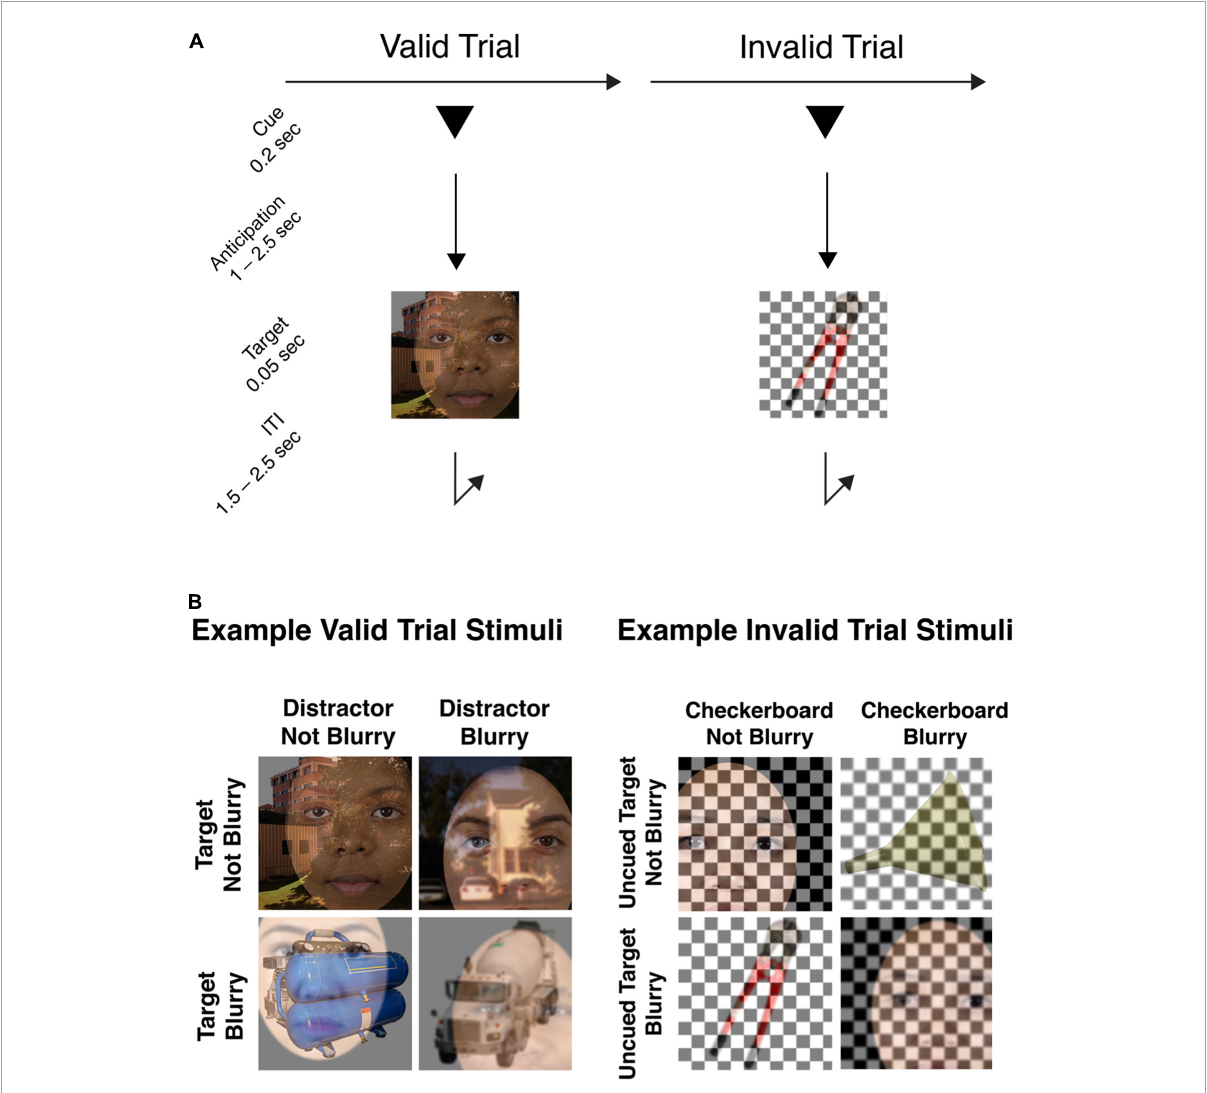
FIGURE1 (A) Example trial sequence. Each trial began with the presentation of a symbolic cue that was predictive of the upcoming object category (80%). Following an anticipation period (cue-to-target) varying from 1.0 to 2.5 s, a composite stimulus image was presented. Participants were required to make a rapid-accurate discrimination of whether the cued object image was blurry or not-blurry (valid trials), or whether the uncued object image was blurry or not-blurry (invalid trials). (B) Example stimulus images in the attention task. In the set of example valid trial stimuli shown, Face is the target object category to be identified as in-focus or blurry, and the overlaid Tool or Scene images are the distractor images. For each stimulus image, both the target and distractor can be blurry or in-focus, independently of each other. Example invalid trial stimuli are also provided to illustrate that both the uncued target image and the overlaid checkerboard can be blurry or not-blurry, independently of one another. In the invalid trial condition, participants were still trained to respond to the uncued target image with the same blurry/not-blurry distinction, using the same response buttons as for valid trials.